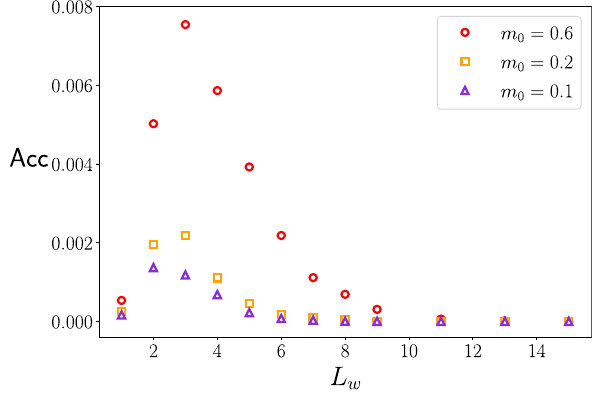
Fig. 7 Acceptance of a winding step in wHMC as a function of L w for various bare quark masses at β = 5 . 0